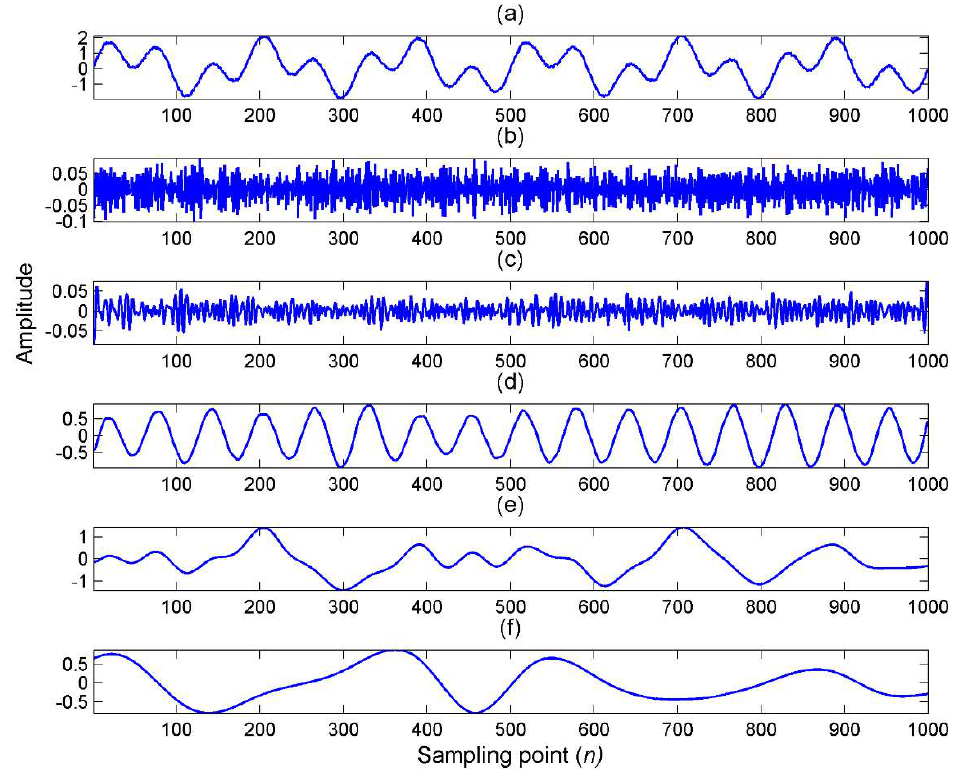
Figure 4. Decomposition of the artificially mixed signal with 20% additive noise by ICEEMD: ( a ) the signal; ( b ) IMF1 of the signal; ( c ) IMF2 of the signal; ( d ) IMF3 of the signal; ( e ) IMF4 of the signal; and ( f ) IMF5 of the signal.